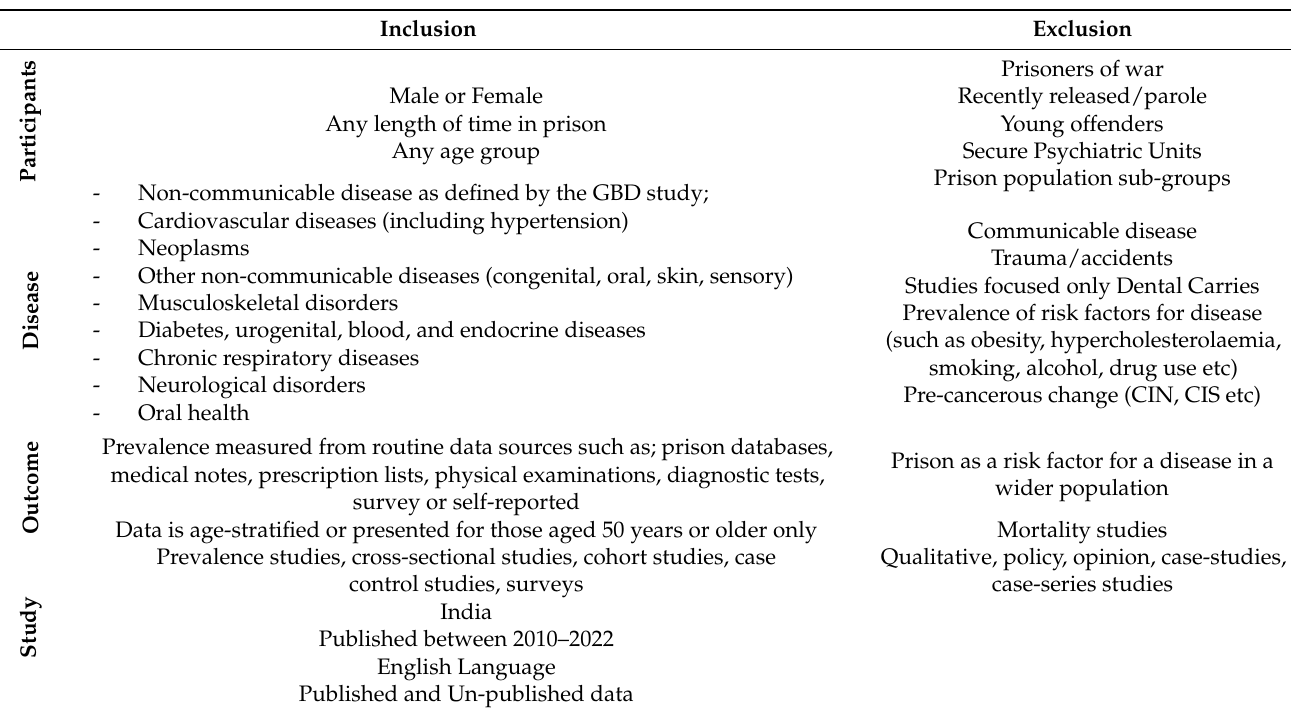
Table A2. Inclusion and exclusion